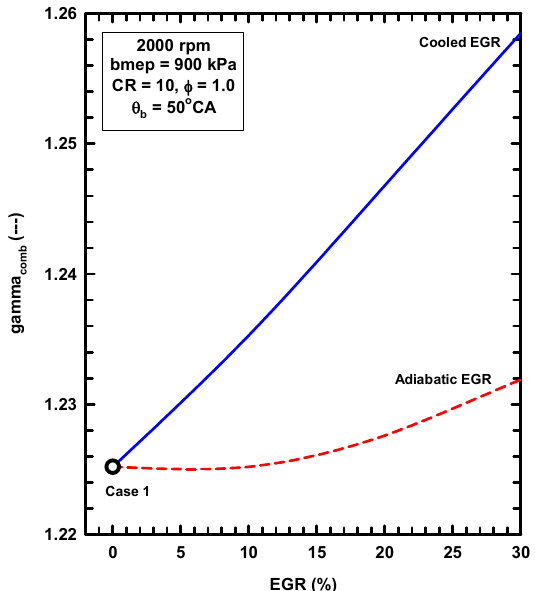
Figure 17. The average ratio of specific heats during combustion as functions of the EGR percentage for the two EGR configurations.